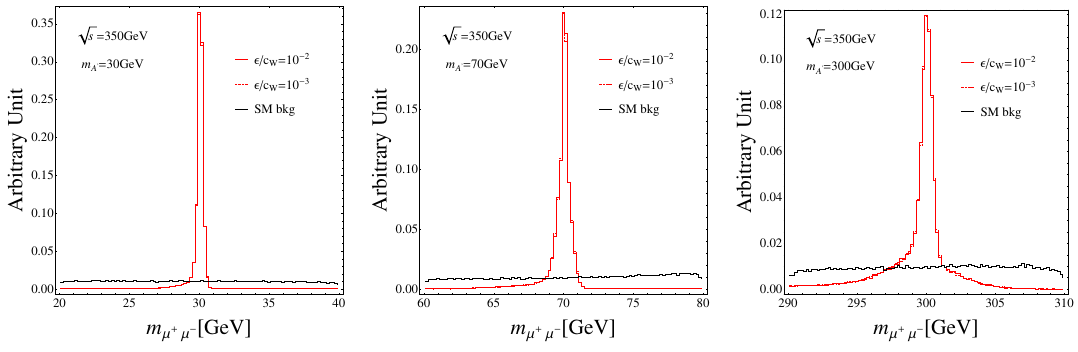
Figure 3 . The normalized m distributions for m A 0 = 30 GeV, 70 GeV, 300 GeV with (cid:15)=c W = (cid:22) + (cid:22) (cid:0) p 10 (cid:0) 2 and (cid:15)=c W = 10 (cid:0) 3 at s = 350 GeV. The distributions are not sensitive to the total width and thus (cid:15) for (cid:15)=c W (cid:24) 10 (cid:0) 3 {10 (cid:0) 2 . After passing these pre-selection criteria, the invariant mass distributions of (cid:22) + (cid:22) (cid:0) are displayed in (cid:12)gure 3, where we have chosen three benchmark values of m , i.e., A 0 m = 30 GeV, 70 GeV, 300 GeV, with (cid:15)=c = 10 (cid:0) 2 and 10 (cid:0) 3 at the FCC-ee with W A 0 p p s = 350 GeV (the results are similar at the CEPC with s = 240 GeV and the FCC- p ee with s = 160 GeV). The invariant mass distributions of (cid:22) + (cid:22) (cid:0) are a(cid:11)ected by the muon momentum resolution and the total width of dark photon, which is proportional to (cid:15) 2 . Figure 3 shows that for (cid:15)=c (cid:24) 10 (cid:0) 3 {10 (cid:0) 2 the impact of the dark photon total width W on the invariant mass distributions is negligible. Thus it is (cid:13)exible to choose (cid:15)=c = 10 (cid:0) 2 , W